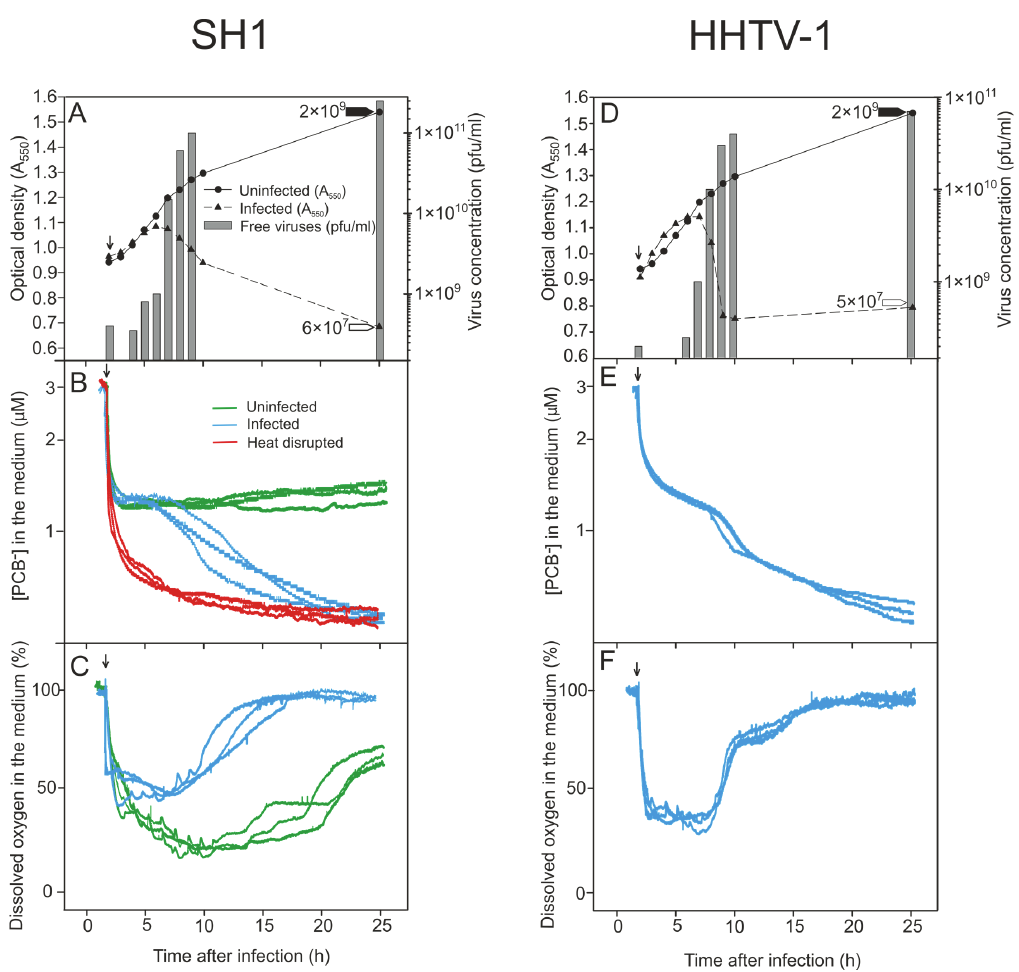
Figure 2. Growth parameters and physiological changes in Haloarcula hispanica during infection by ( A – C ) SH1 and ( D , F ) HHTV-1 (MOI of 20). Unadsorbed viruses were removed at 2 h p.i. and measurements were begun at 2 h 15 min p.i. (indicated by arrows) and were carried out in MGM medium at 37 °C with aeration. ( A , D ) Turbidities of the infected and uninfected cultures; the number of free progeny viruses (pfu/mL) in the infected cultures; and the number of viable cells (cfu/mL) at 25 h p.i. in the uninfected ( black arrow head) and infected cultures ( white arrow head); ( B , E ) PCB − binding in the presence of PCB − (calibrated with 3 µM PCB − ) to infected, uninfected, and heat disrupted (showing the maximal binding) Har. hispanica cells ( n = 3); ( C , F ) The level of dissolved oxygen in the medium of infected and uninfected Har. hispanica cells ( n = 3).